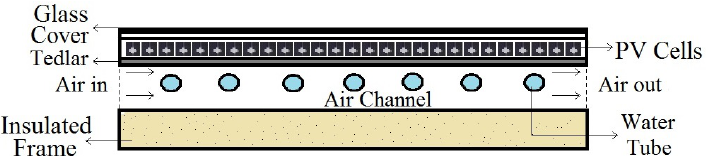
Figure 6. Sectional view of bi-fluid based PV/T